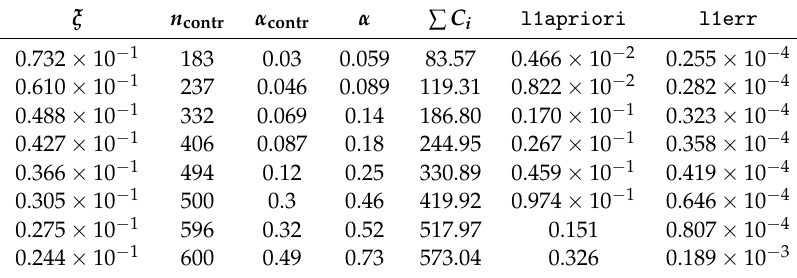
Table 2. Summary of the L 1 bounds on the approximation error obtained for the range of noises ξ , for the system Equation (2) with the alternative value A =